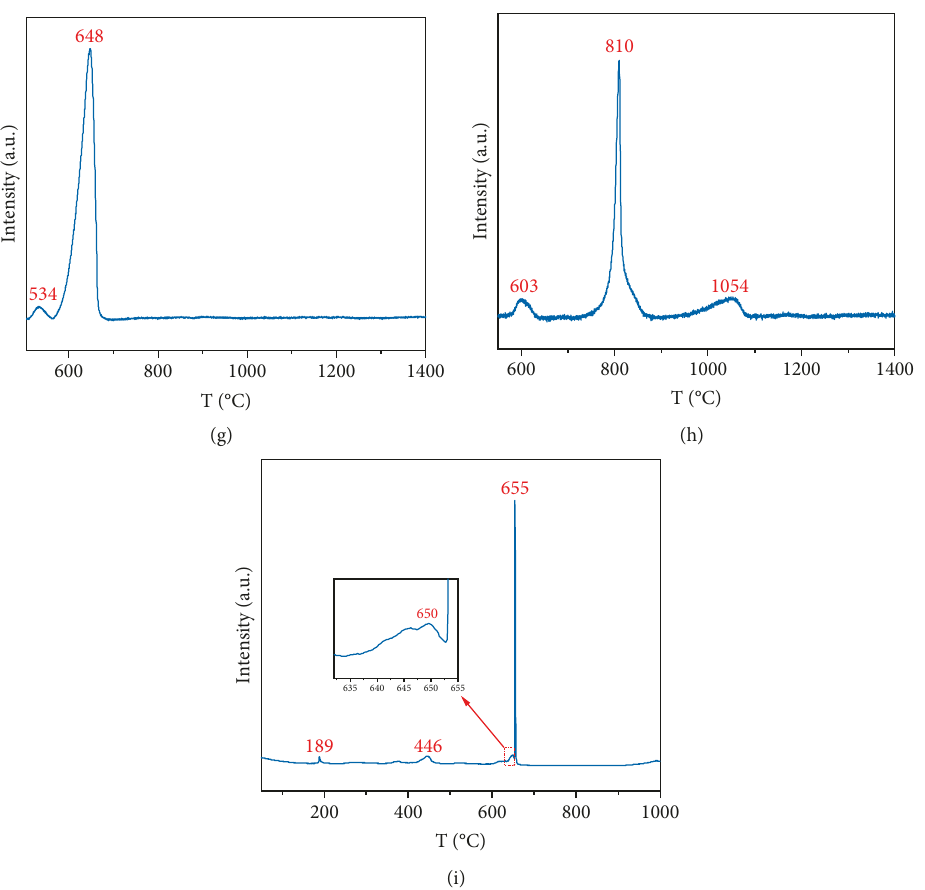
Figure 3: TPO-IR curve of sulfur species with known structures: (a) ZnS; (b) CoS; (c) Cu (g) FeSO 4 · 7H 2 O; (h) (NH 4 )2S 2 O 8 ; (i) C 18 H 29 NaO 3 for CoS (Figure 3(b)) and FeSO